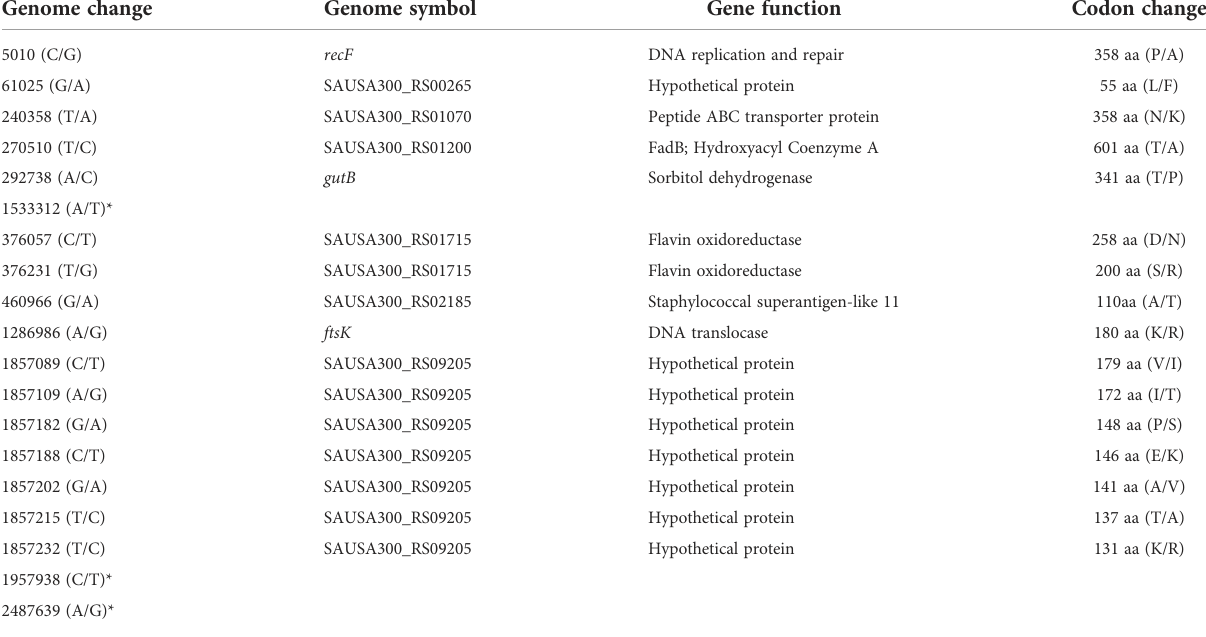
TABLE 2 SNPs of nasopharyngeal colonization isolates that persisted across repeated